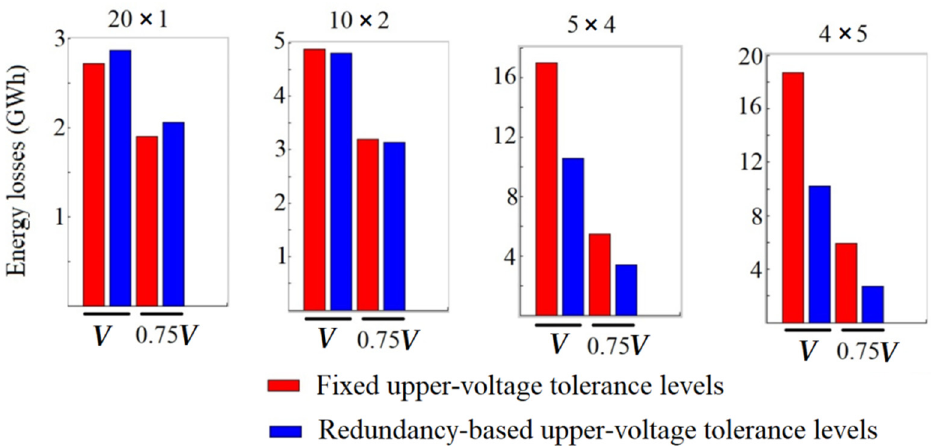
Figure 4. Comparison of AEC losses with fixed and redundancy-based upper-voltage tolerance levels for different wind farm configurations.